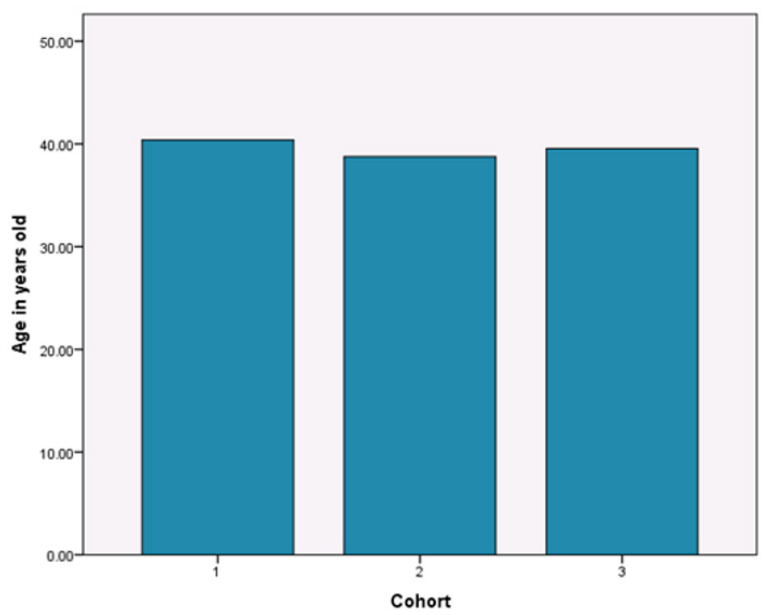
Figure 1. Randomness of Age Distribution.